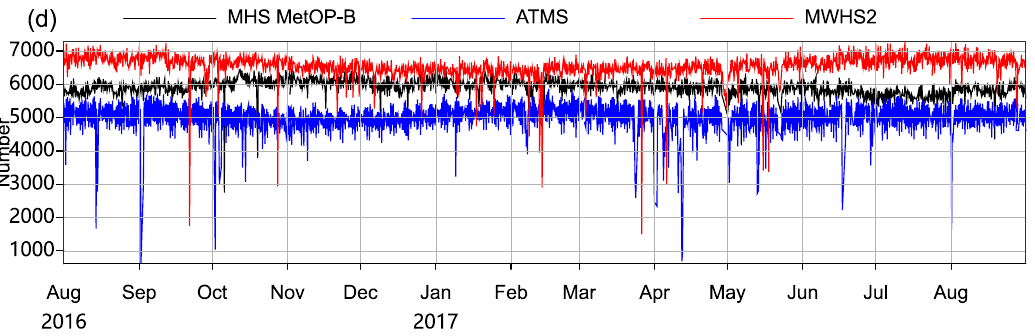
Figure 3. Time series of the Stdv of O − B ( a ), O − A ( b ), and O − B minus O − A ( c ), as well as the number of observations ( d ) for MWHS-2 channel 13 (red line), SNPP ATMS channel 20 (blue line) and MetOP-B MHS channel 4 (black line).